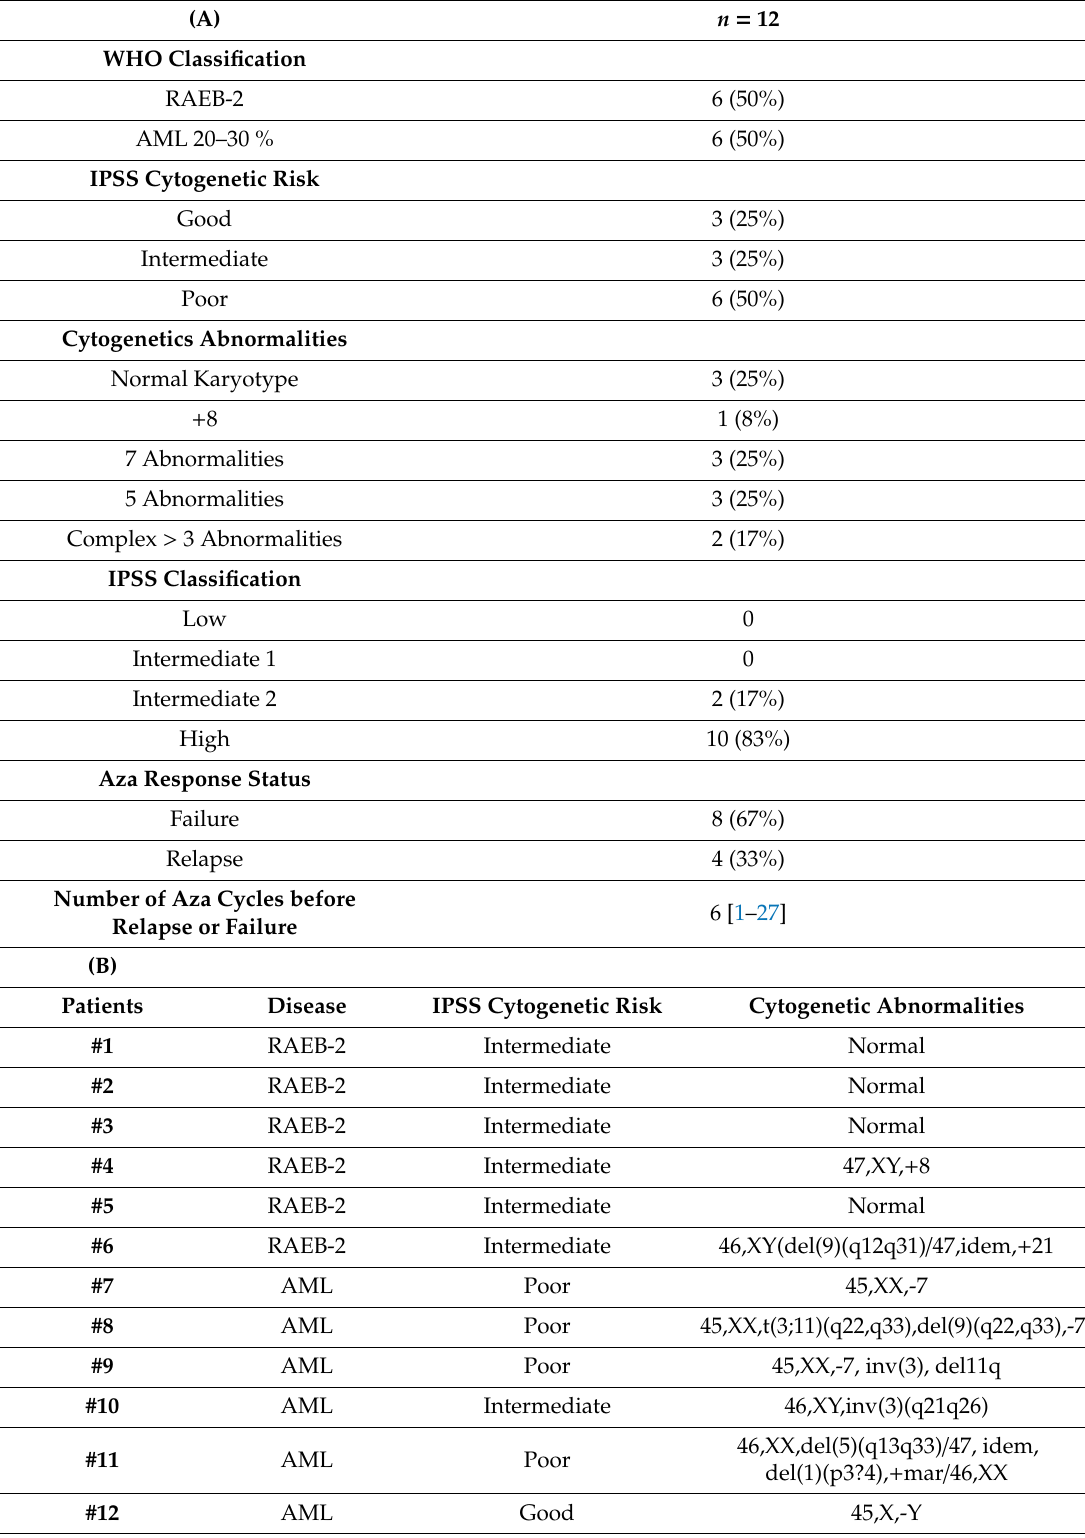
Table 1. Patients’